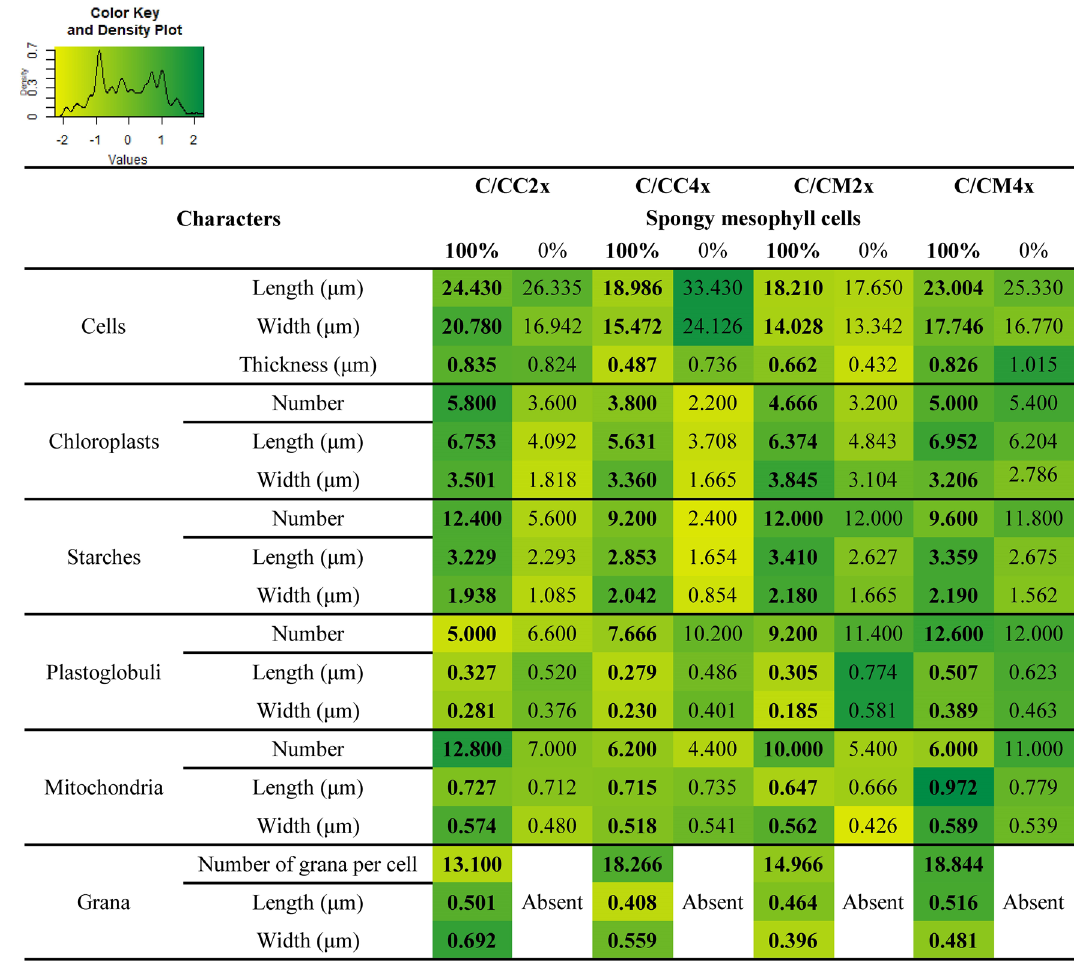
Table 4. Ultrastructure of spongy mesophyll cells of leaves of common clementine scion grafted onto different rootstocks. Ultrastructure characters of spongy mesophyll cells of leaves of common clementine scion grafted onto diploid (C/CC2x) and doubled diploid (C/CC4x) Carrizo citrange and diploid (C/CM2x) and doubled diploid (C/CM4x) Citrumelo 4475 rootstocks grown in nutrient reference solution (100%) and without nutrient solution (0%) for 210 days. Values are means (± standard error) of independent measurements on five different cells section ( n = 5) for length, width and thickness of cells and for number of chloroplasts, starches, plastoglobuli and mitochondria and of 30 independent measurements on different cells section ( n = 30) for length and width of chloroplasts, starches, plastoglobuli, mitochondria, grana, number of grana per cells section and number of thylakoids per granum. The heatmap shows the differences between the four scion/rootstocks combinations and treatments for each characteristic. Values are associated with color ranging from yellow (low) to dark green